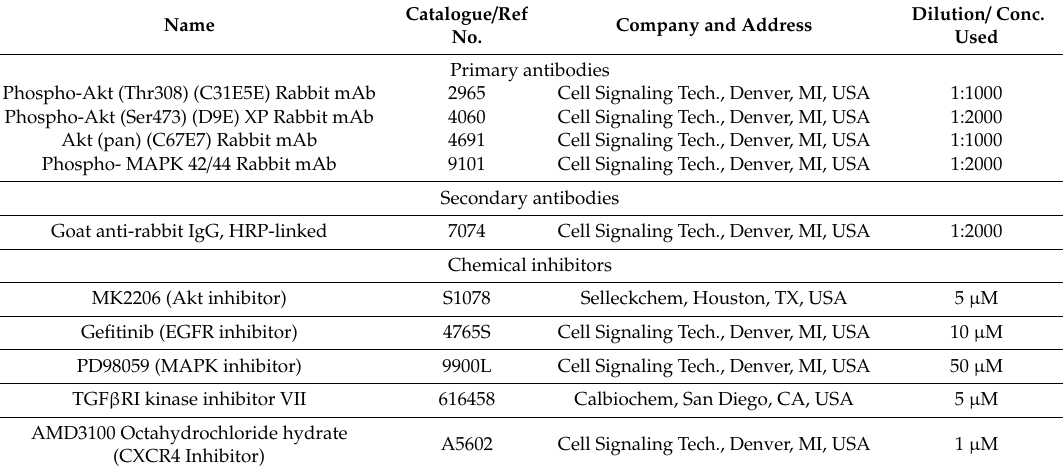
Table 1. Details of the antibodies and inhibitors used in this